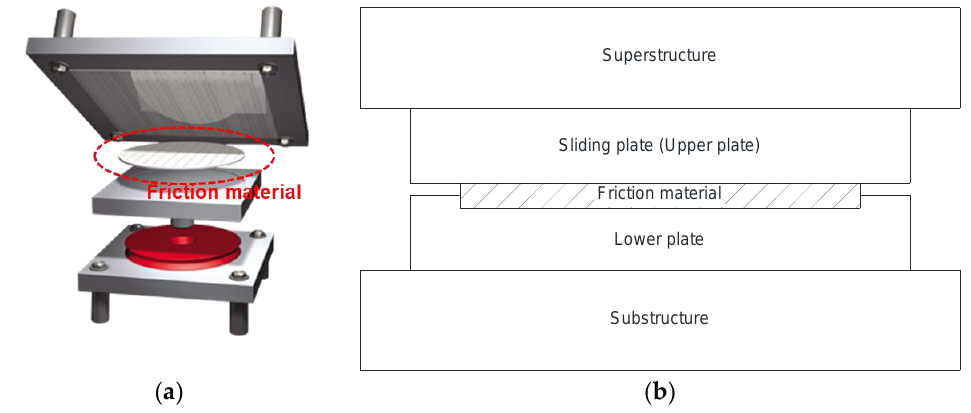
Figure 1. Configuration of bearing support: ( a ) Concept figure; ( b ) Schematic diagram.